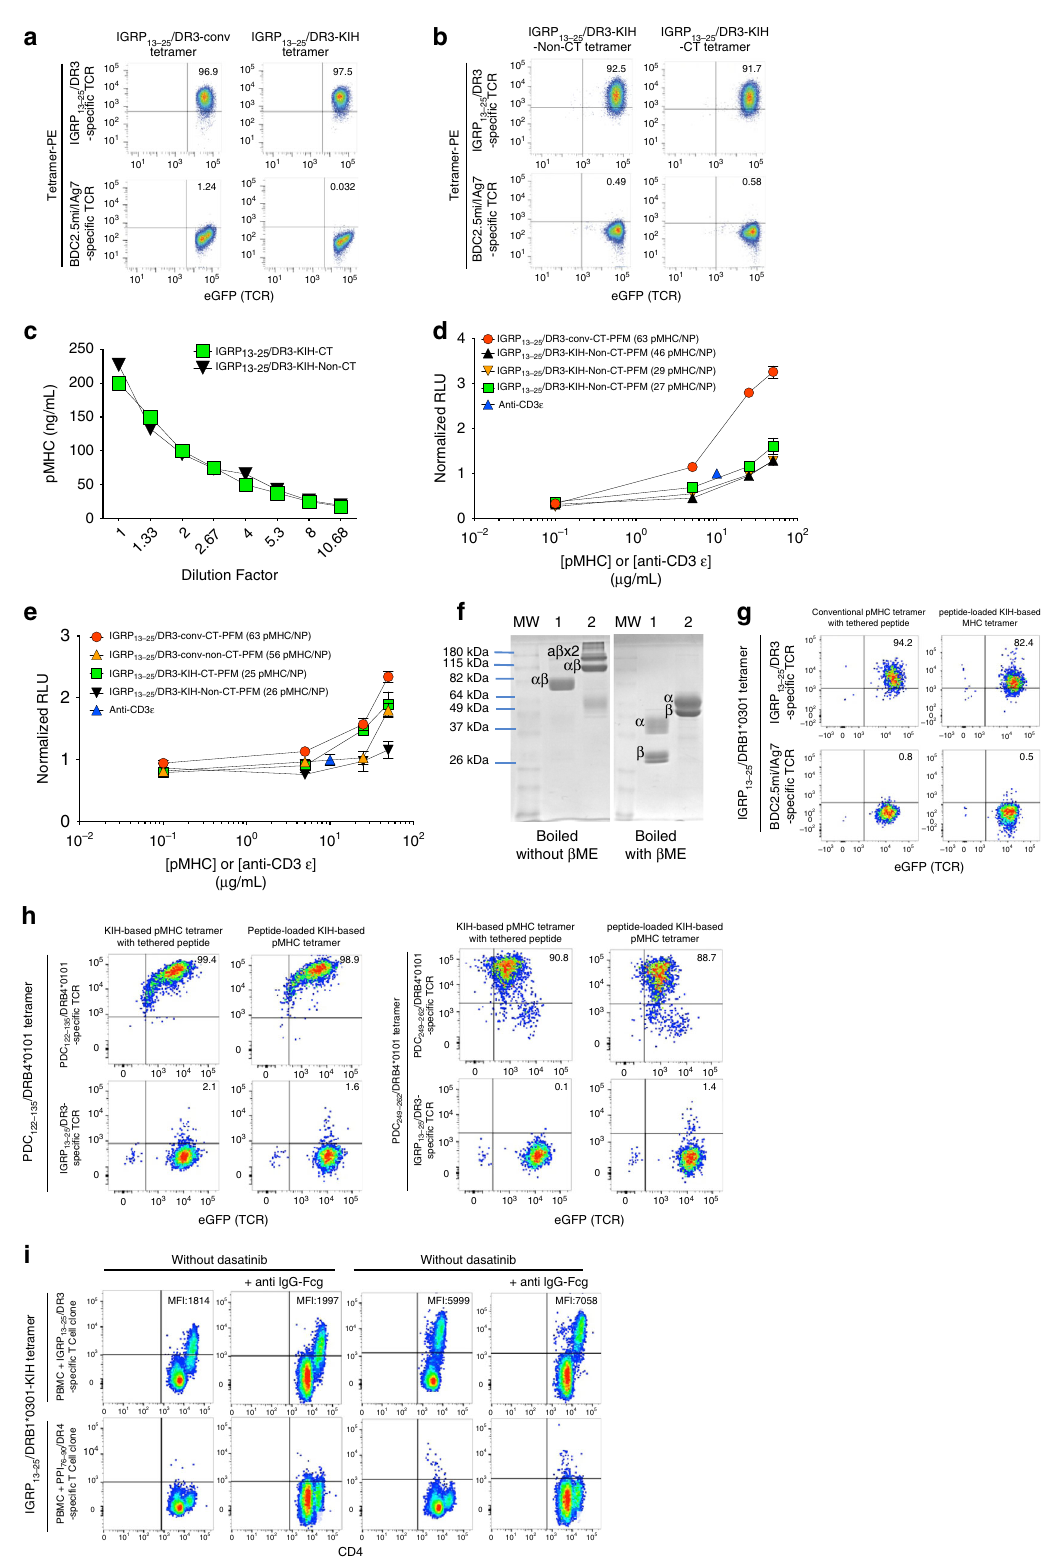
tetramer − subsets by fl ow cytometry. FACS-sorted cells (2 – 3 ×10 4 ) were stimu- lated with anti-CD3/anti-CD28 mAb-coated beads for 48h and the supernatants collected 48h later for measurement of cytokines via Luminex. Statistical analyses . Quantitative data were compared by Mann – Whitney U. Statistical signi fi cance was assumed at P